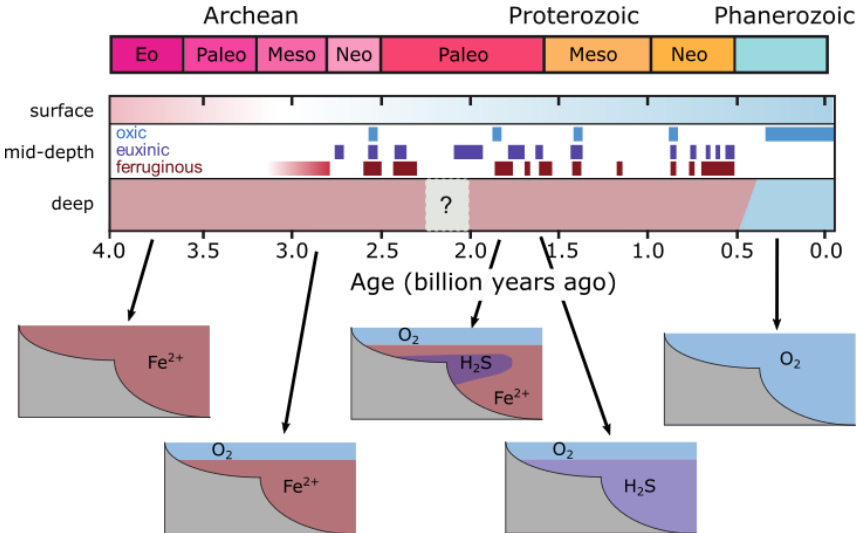
Figure 1. First-order evolution of Earth’s ocean redox landscape. Insets show conceptual models of the spatial redox structure of the ocean at certain points in Earth’s history. Based on Poulton et al. (2010), Poulton and Canfield (2011), and Raiswell and Canfield (2012). After van de Velde et al. (2020b). See text for